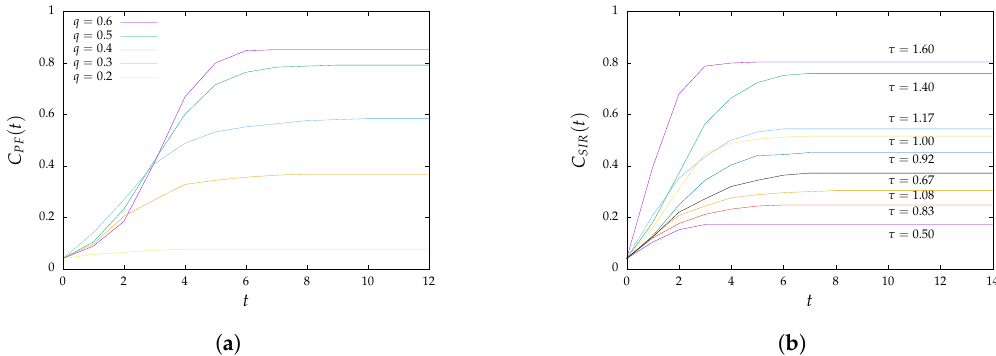
Figure 4. Comparison of coverage with respect to time t in hops between probabilistic flooding and the SIR epidemic model: ( a ) probabilistic flooding coverage C PF ( t ) ; ( b ) SIR epidemic model coverage C SIR ( t )